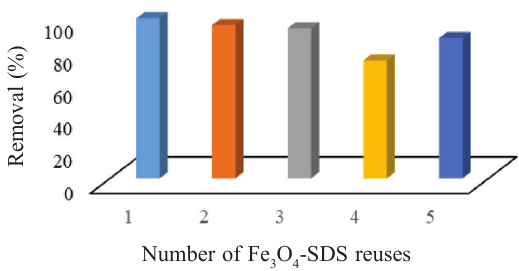
Fig. 9 – Effect of NaCl concentration on removal efficiency of TC onto Fe Table 1 – Effect of ions and dyes intervention on TC removal Type of studied ions and dyes